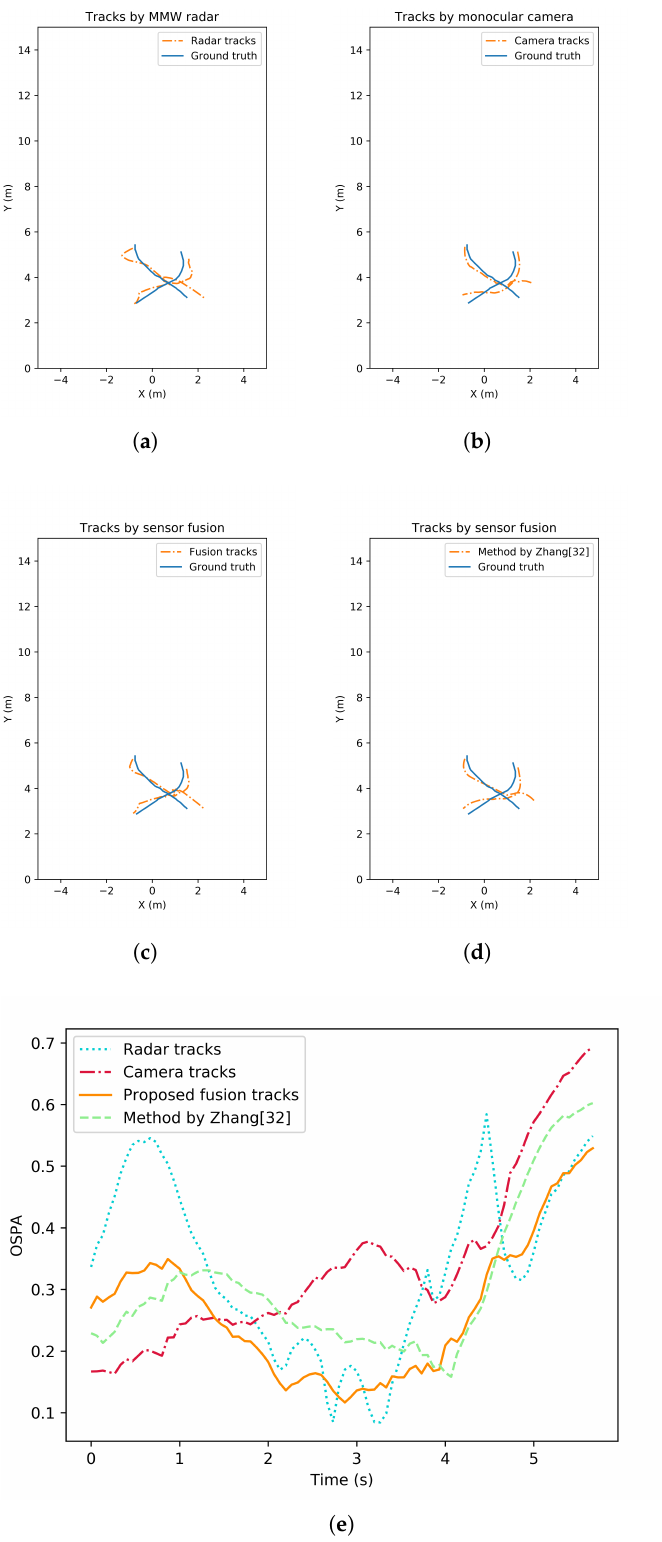
Figure 9. Pedestrian tracking performance comparison under crossover targets situation. ( a ) Tracking trajectories by MMW radar. ( b ) Tracking trajectories by monocular camera. ( c ) Tracking trajectories by the proposed fusion strategy. ( d ) Tracking trajectories by the method from [32]. ( e ) Tracking performance comparison in